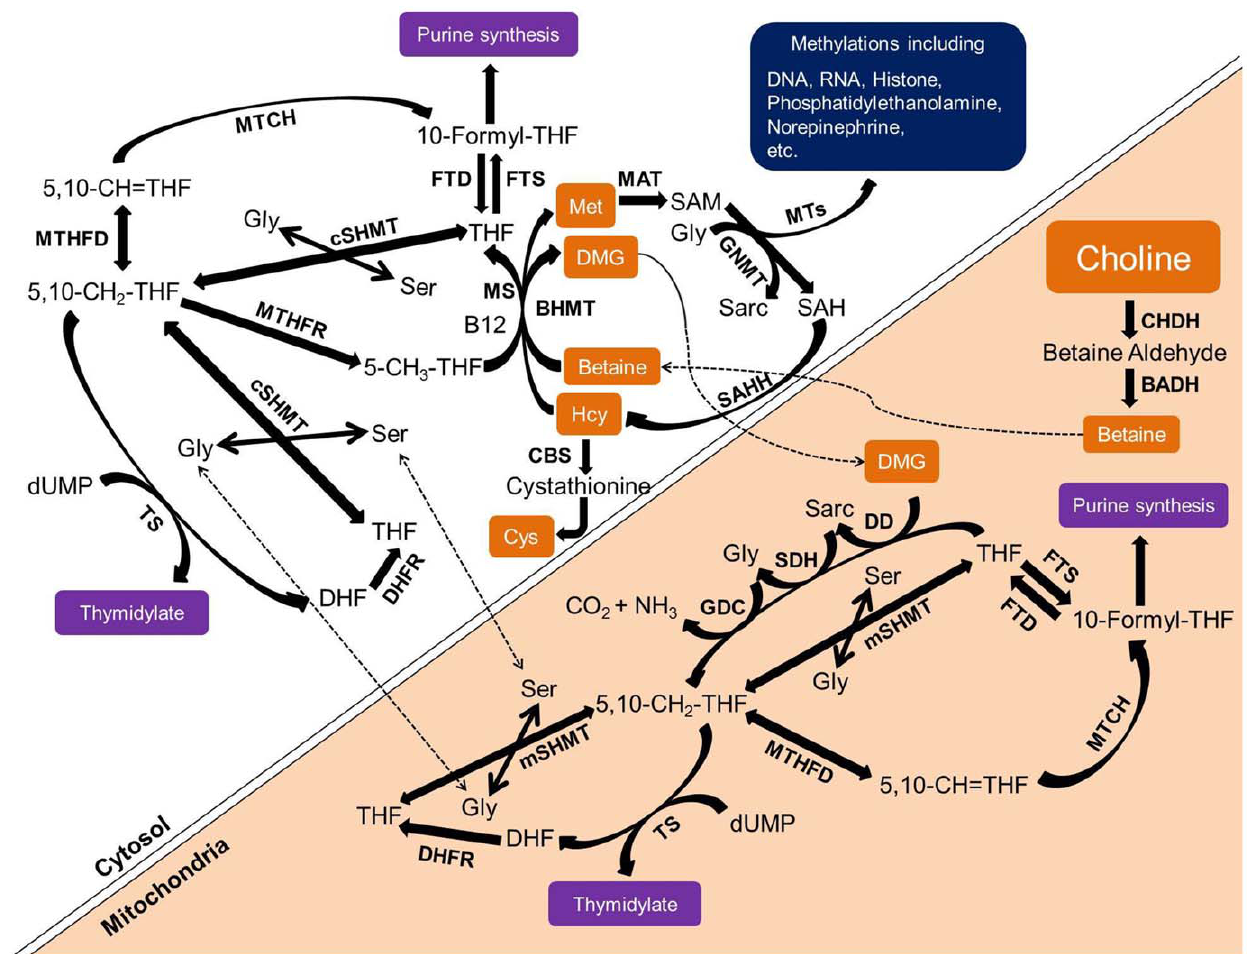
Figure 2. Schematic to show the role of choline in one-carbon metabolism intersecting with the methionine-homocysteine cycle. Measured metabolites are shown in orange boxes; enzymes are shown in bolded alphabets. 10-Formyl-THF: 10-formyl-tetrahydrofolate; 5,10- CH=THF: 5,10-methenyltetrahydrofolate; 5,10-CH2-THF: 5,10-methylenetetrahydrofolate; 5-CH3-THF: 5-methyltetrahydrofolate; BADH: betaine aldehyde dehydrogenase; BHMT: betaine-homocysteine S -methyltransferase; CBS: cystathionine beta synthase; CHDH: choline dehydrogenase; Cys: cysteine; cSHMT: cytoplasmic serine hydroxymethyltransferase; DD: dimethylglycine dehydrogenase; DHF: dihydrofolate; DHFR: dihydrofolater- eductase; DMG: dimethylglycine; dUMP: 2 9 -deoxyuridine 5 9 -monophosphate; FTD: 10-formyl-tetrahydrofolate dehydrogenase; FTS: 10-formyl- tetrahydrofolate synthase; GDC: glycine decarboxylase; Gly: glycine; GNMT: glycine N -methyltransferase; Hcy: homocysteine; MAT, methionine adenosyltransferase; Met: methionine; MS: methionine synthase; mSHMT: mitochondrial serine hydroxymethyltransferase; MTCH: 5,10- methylenetetrahydrofolate cyclohydrolase; MTHFD: 5,10-methylenetetrahydrofolate dehydrogenase; MTHFR: 5,10-methylenetetrahydrofolate reductase; MTs, S -adenosyl methionine-dependent methyltransferases; SAH, S -adenosyl homocysteine; SAHH: S -adenosyl homocysteine hydrolase; SAM: S -adenosyl methionine; Sarc: sarcosine; SDH: sarcosine dehydrogenase; Ser: serine; THF: tetrahydrofolate; TS: thymidylate synthase. Not all enzymes and intermediates are shown in this